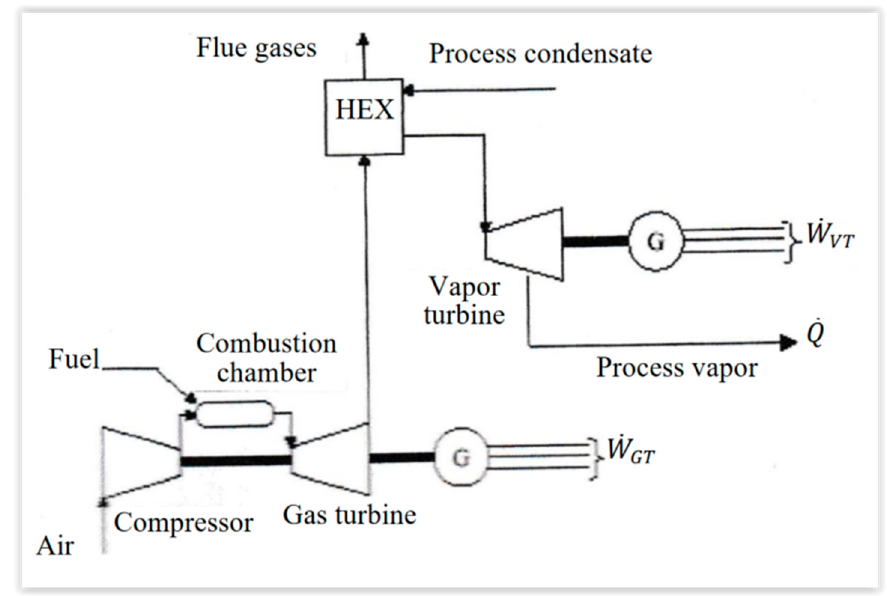
Figure 5. Combined cycle Gas Turbine + Vapor Turbine and cogeneration [20].